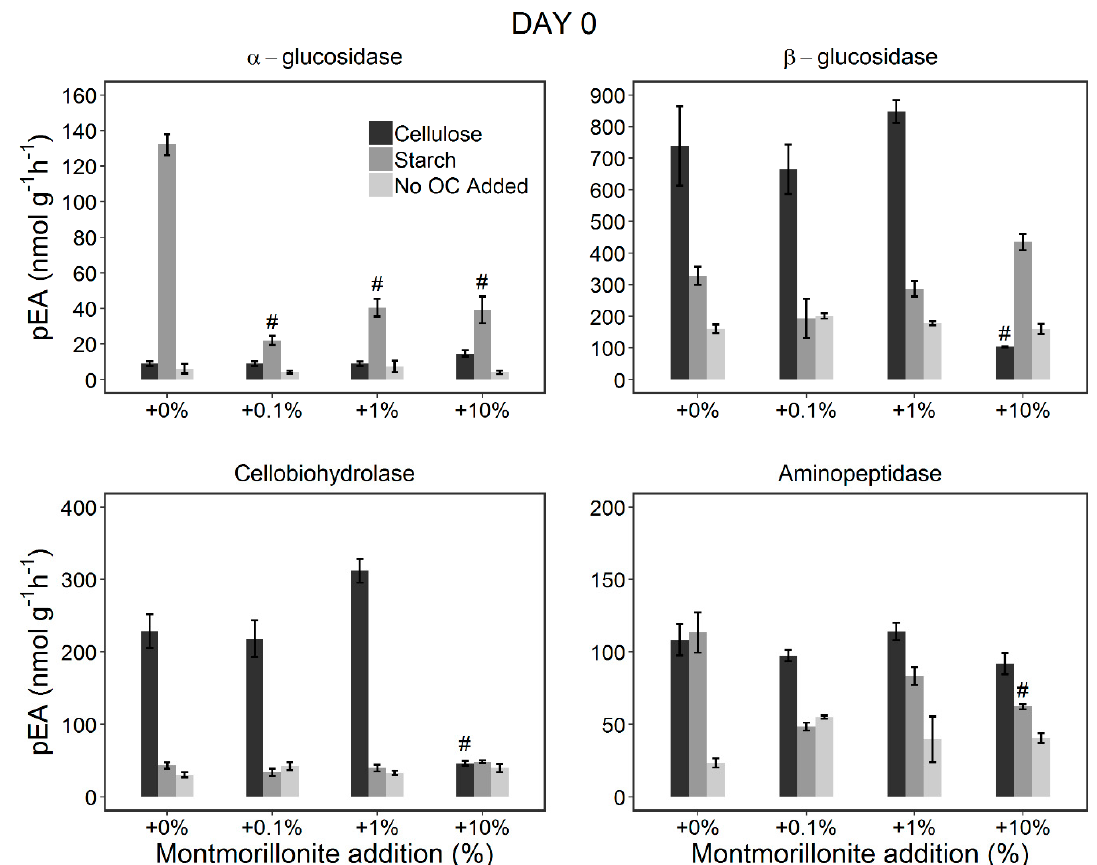
Figure 2. The potential enzyme activities (pEA) of α -glucosidase (AG), β -glucosidase (BG), cellobiohydrolase (CB), and aminopeptidase (AM) measured in the soil manipulated by increasing montmorillonite addition without added OC or with the addition of OC (starch or cellulose) at day 0 of the incubation. Error bars represent standard error of means (n = 3). Bars with statistically significant difference ( p < 0.05) from the control (+0%) are marked with # (decrease in pEA). Mean comparison was done among treatments in the same group (cellulose or starch).